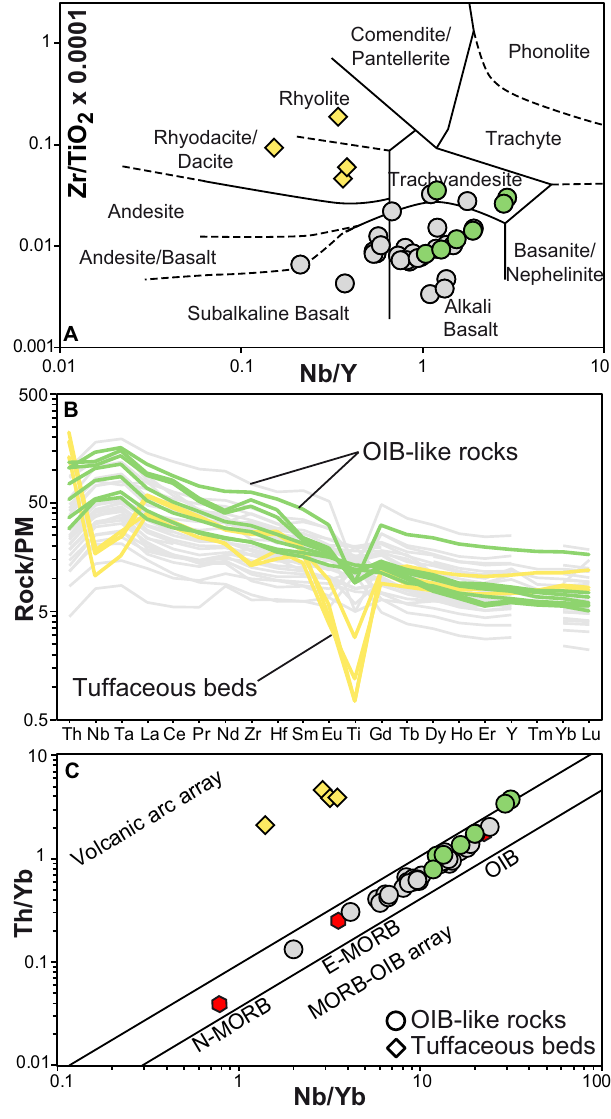
Fig. 3 Geochemistry of OIB-like rocks from the Texas Beds. Data: this study (yellow diamonds, green circles) and from ref. 35 (gray circles). Plots after: A 64 , C 65 . B Primitive mantle (PM) after ref. 66 . C Average enriched mid-ocean ridge basalt (E-MORB), normal (N-MORB), and ocean island basalt (OIB) after ref. 67